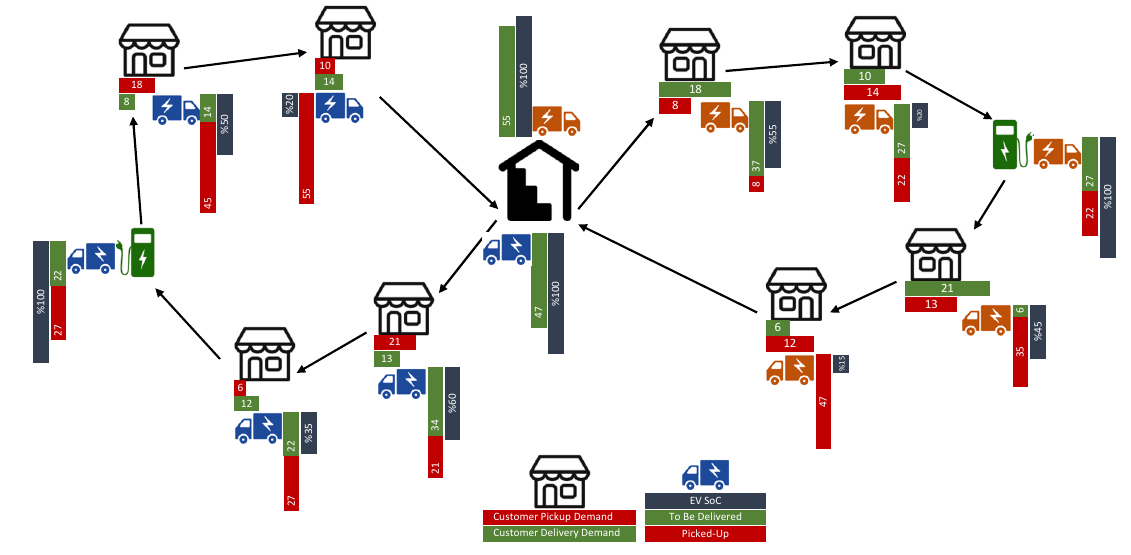
Figure 1. An illustration of the EVRP-SPD .